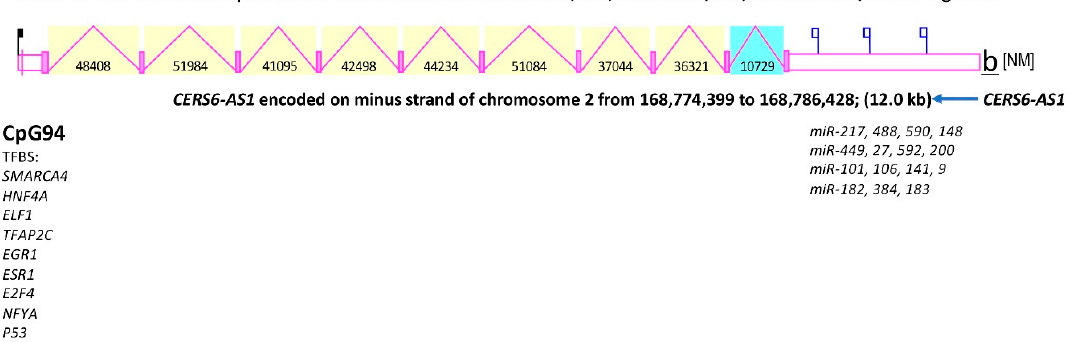
Figure 5. Structure of the human CERS6 gene. Derived from the AceView website [40]; the major isoform variant is shown with capped 5 ′ - and 3 ′ -ends for the predicted mRNA sequences; introns (pink lines) and exons (pink boxes) are shown; the length of the messenger RNA (mRNAs) (as kilobases or kb) are shown; a CpG island (CpG94) is shown for the CERS6 promoter; 15 miRNA binding sites were identified for the 3 ′ UTR of the human CERS6 gene; the direction for transcription is shown; TFBS refers to transcription factor binding sites located within the CERS6 promoter; CERS6-AS1 refers to an antisense gene located proximal to CERS6 .